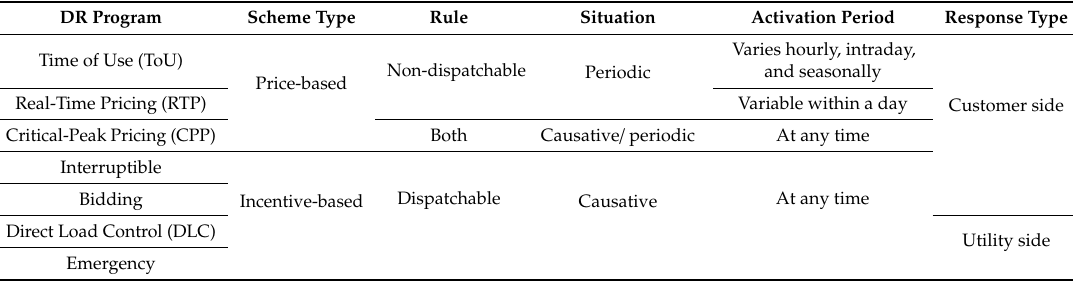
Table 1. Comparison for demand response (DR) programs.